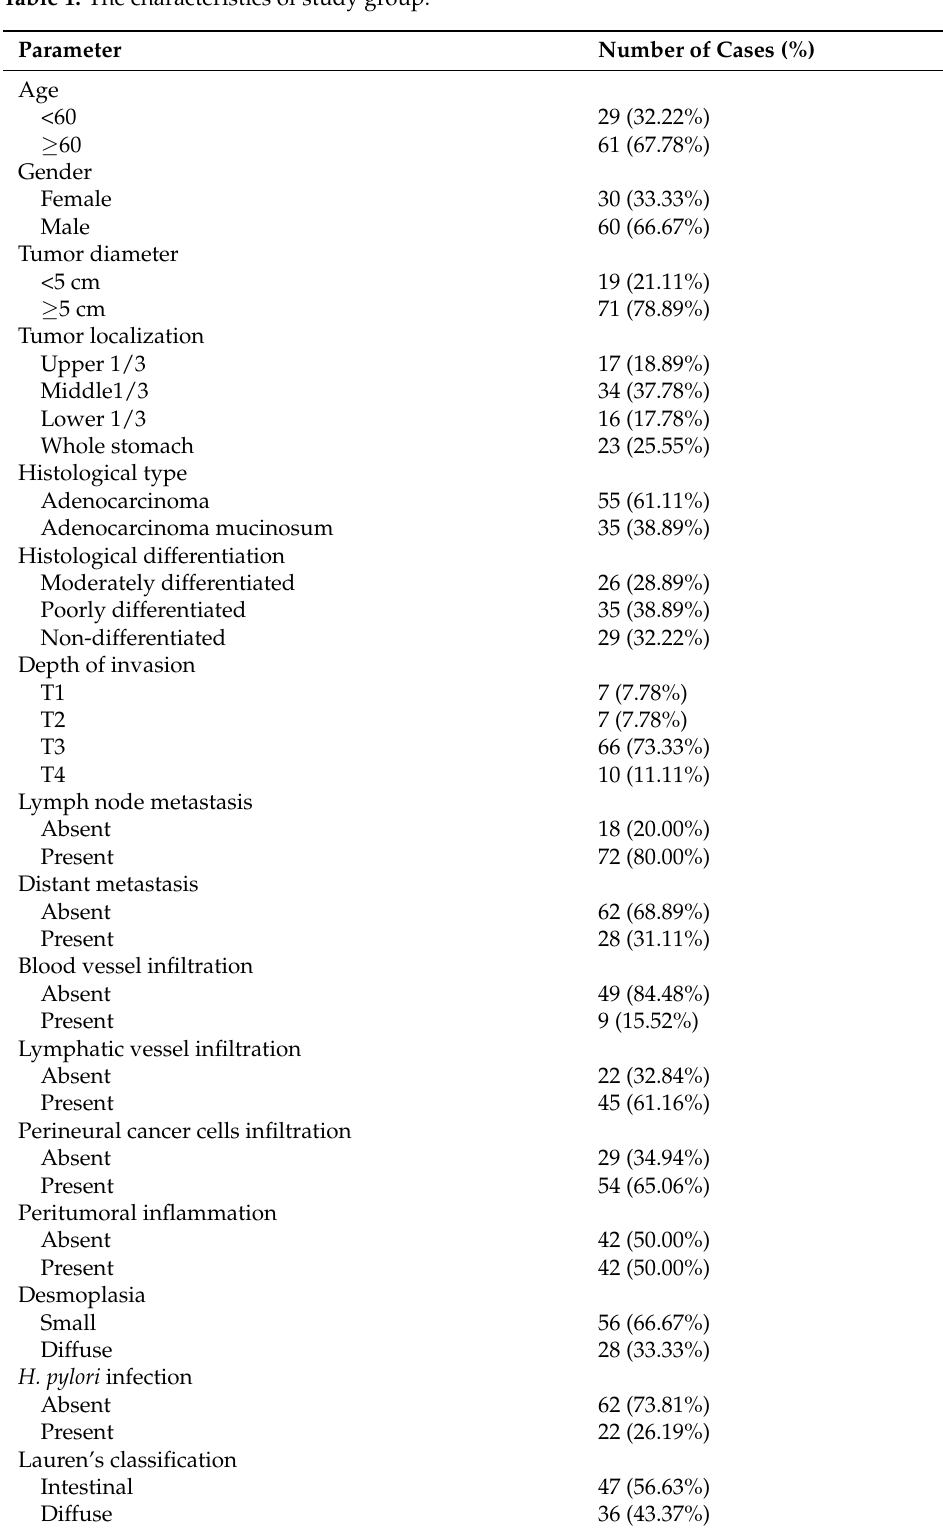
Table 1. The characteristics of study